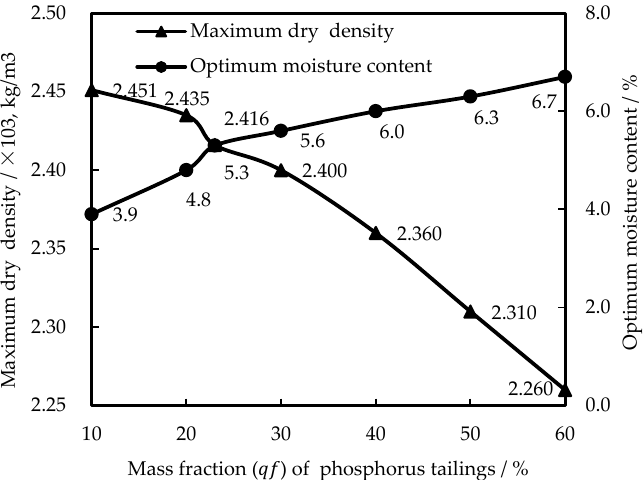
Figure 11. Heavy compaction results of phosphorus tailing – graded waste rock mixture.